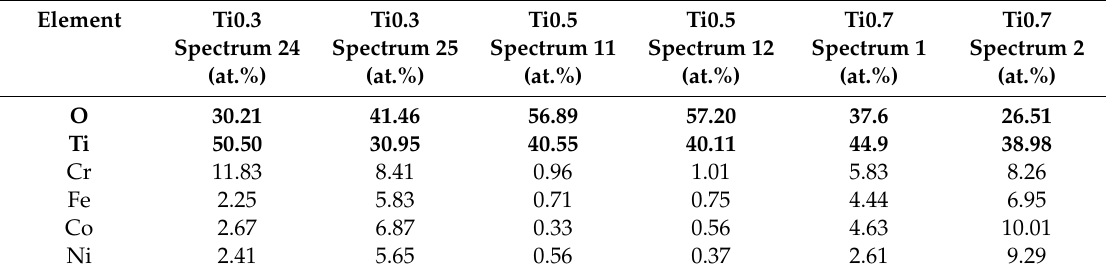
Table A1. Chemical compositions of the oxides from Figure A1. The black dots represent oxide particles enriched mostly in Ti. The point EDS analysis cannot be considered as perfectly accurate measurement of chemical composition because even the largest of the oxides are still very small and the EDS signal coming out of them is contaminated by the signal from the Ni, Co, Cr and Fe rich FCC matrix below the particles. Therefore, residual traces of Ni, Co, Cr and Fe are probably a background noise. Element